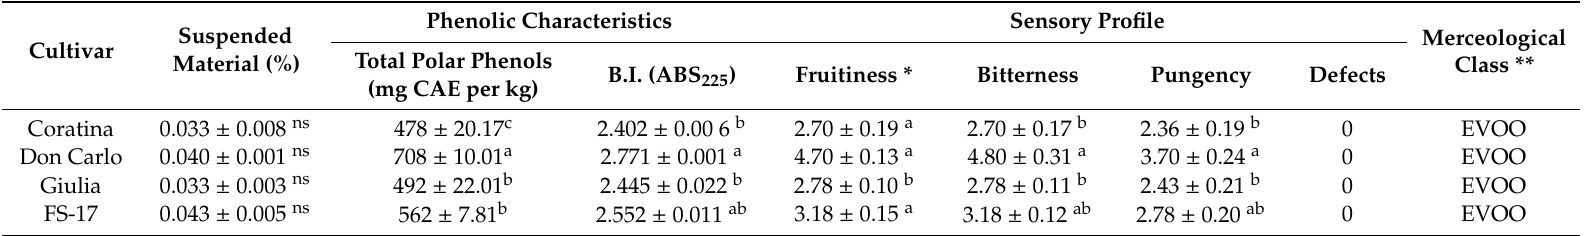
Table 1. Physicochemical and sensory profiles of four monocultivar EVOO characterized by high Bitter Index and total phenols used as a blending source.